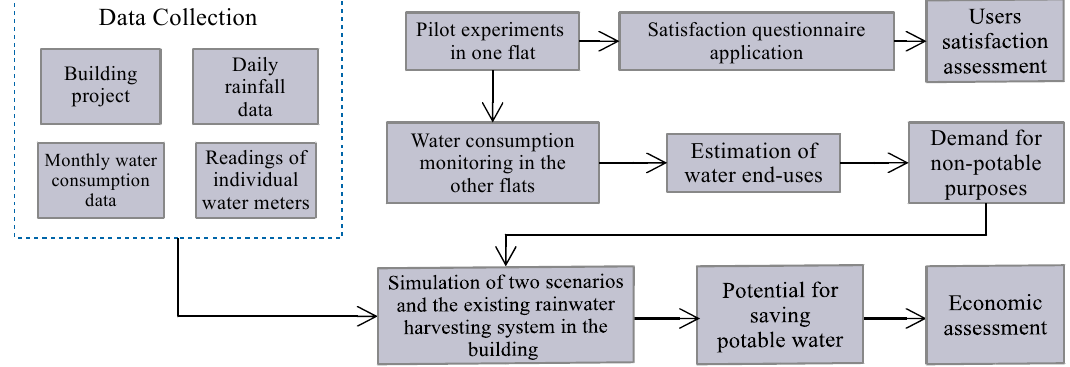
Figure 1. Performed for economic and user satisfaction assessments regarding rainwater harvesting system.